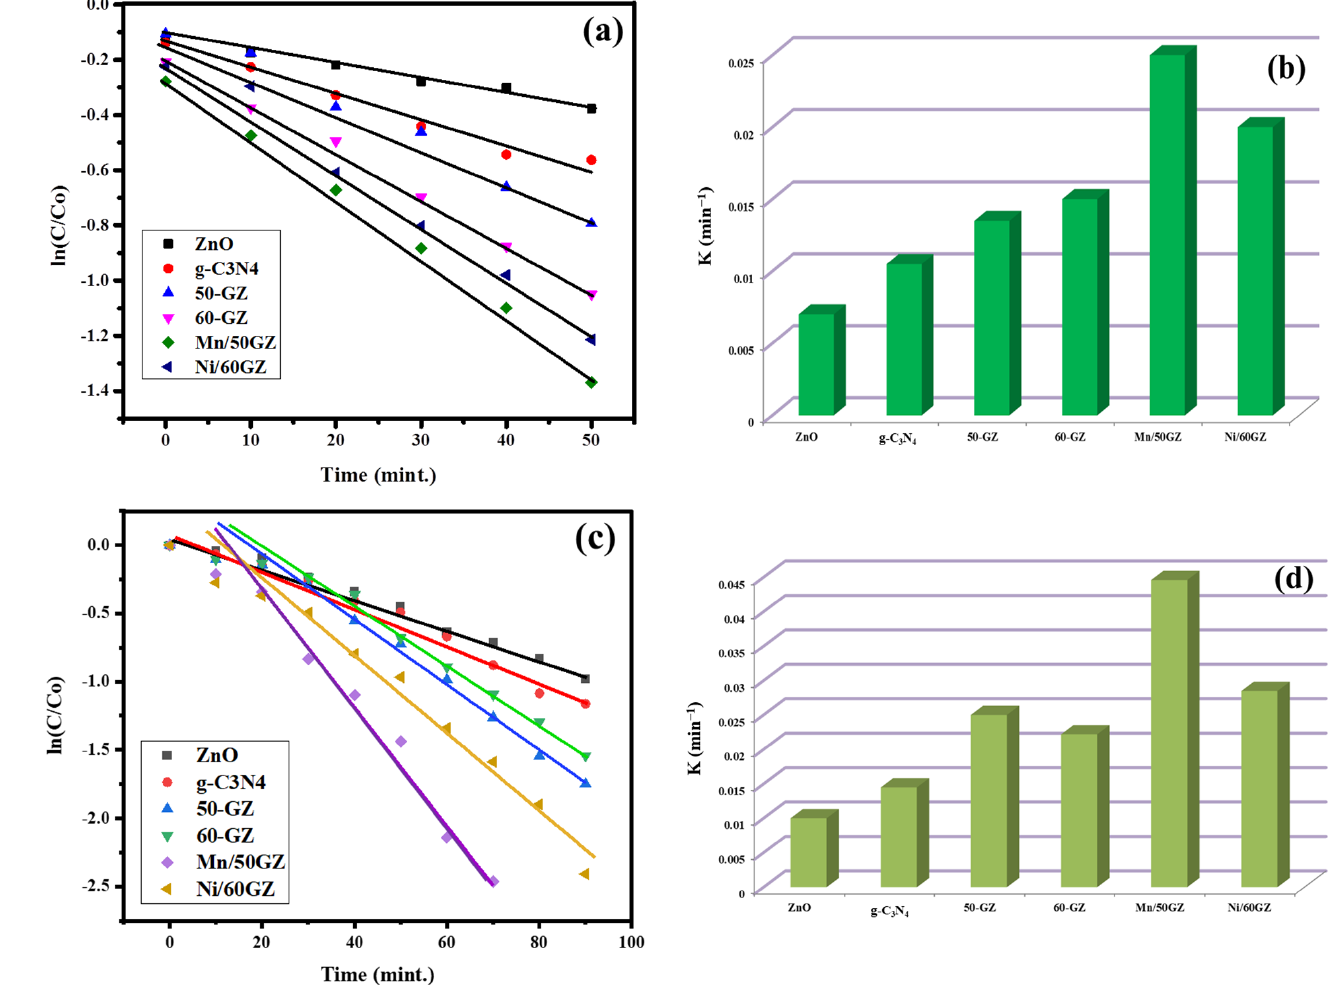
Figure 10. EBT decoloration kinetic characteristics ( a ) and k (min − 1 ) values ( b ) and MO decoloration